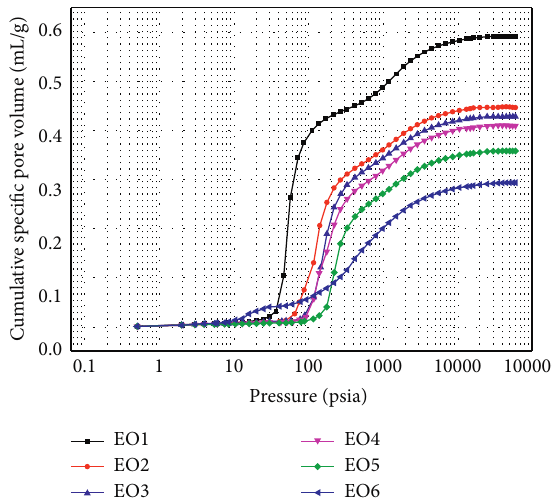
Figure 8: Total pore volume in anode soils.